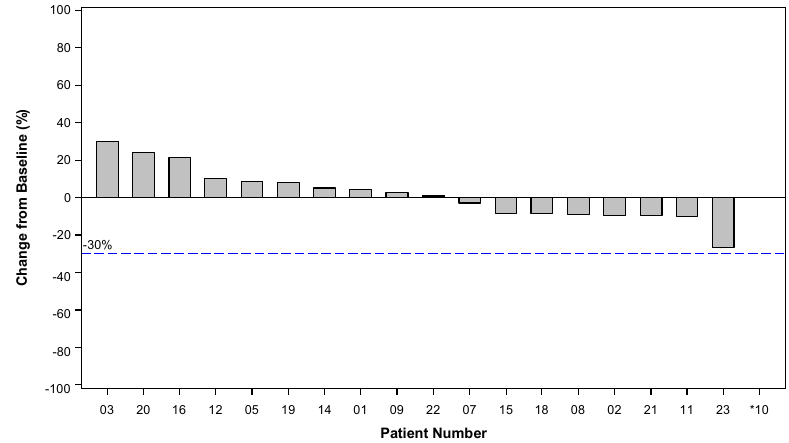
Figure 2. Percentage change in target lesion measurements from baseline. Best Response of the Sum of the Longest Target Lesion Diameters. Patient 10 exhibited new metastatic disease and was removed from the study without measurement of target lesions.